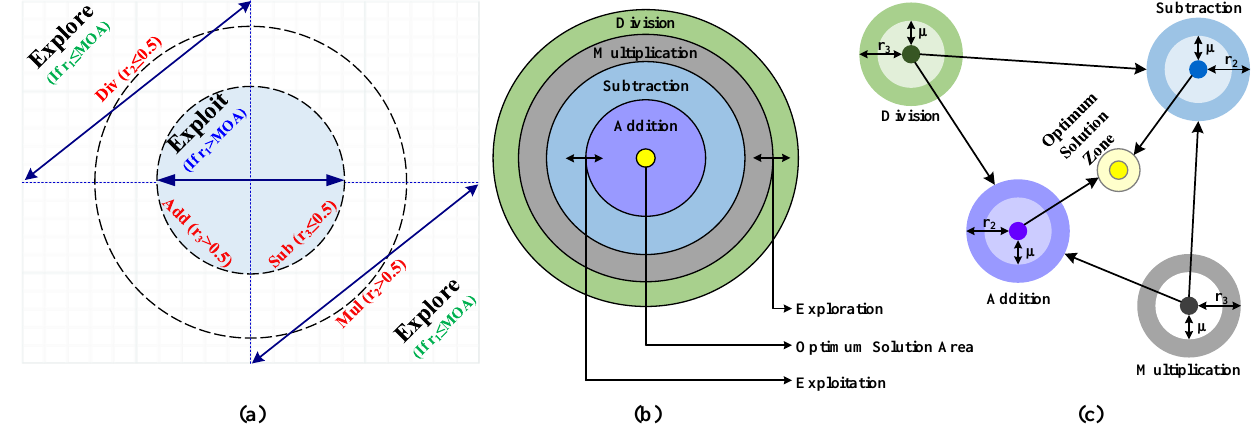
Figure 2. Illustration of AOA algorithm; ( a ) search phases of the AOA; ( b ) hierarchy of the arithmetic operators; ( c ) position update towards the optimum